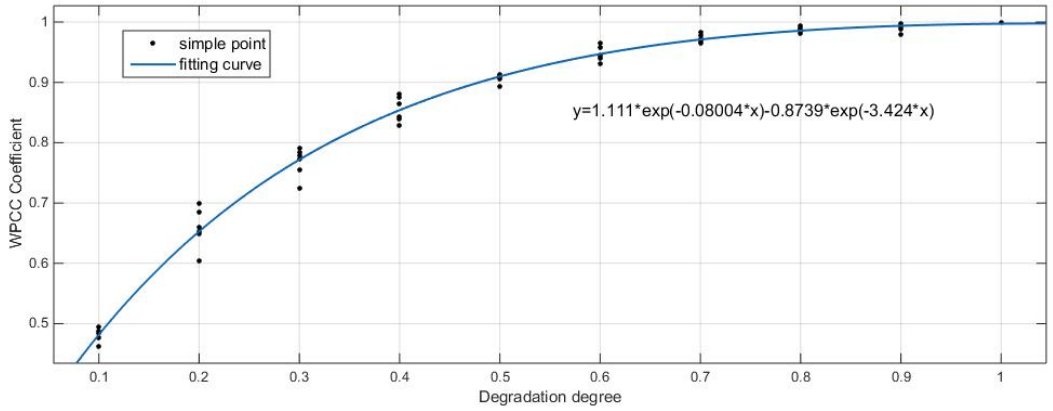
Figure 6. WPCC Coe ffi cients function. Figure 6. WPCC Coefficients function.